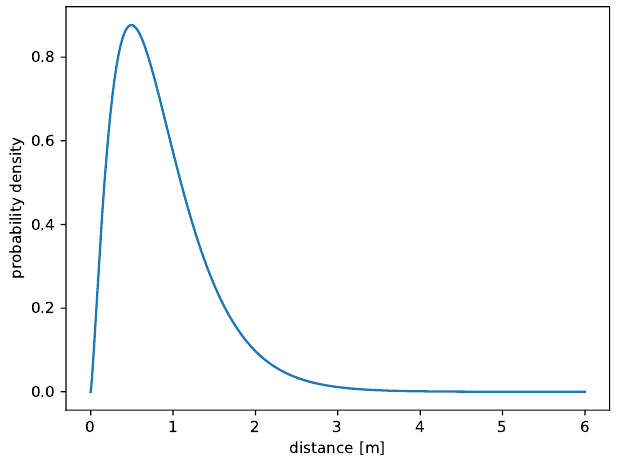
Figure 2. Gamma distribution ( 2.33,0.37 ) fitted to GPS horizontal